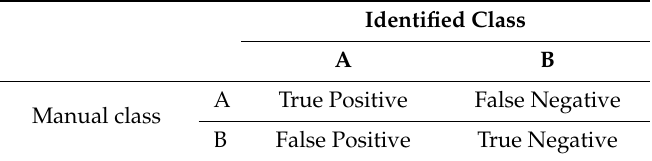
Table 2. Confusion matrix.